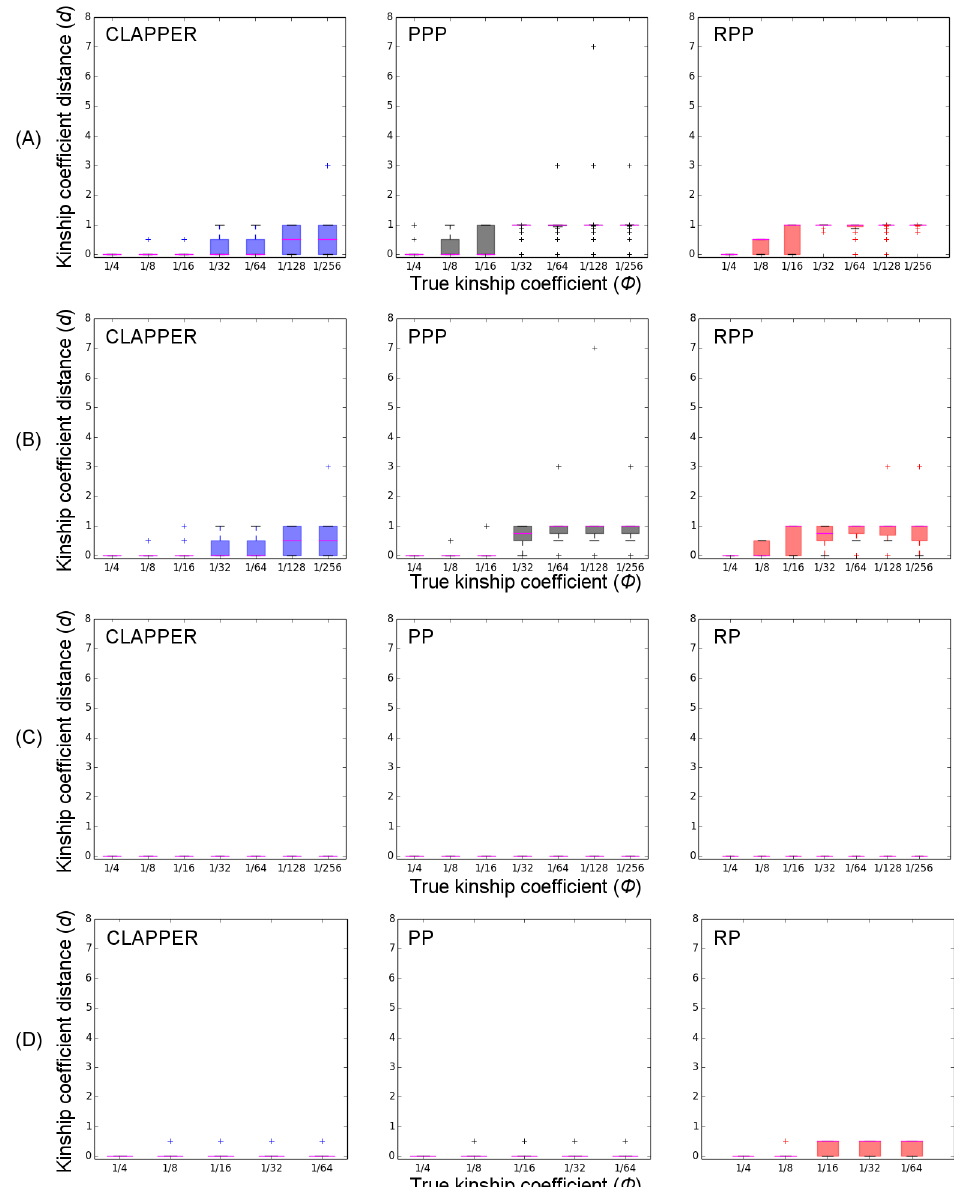
Fig 4. Absolute between the expected kinship coefficient under true and inferred relationships, normalized by the true kinship coefficient. (A) simulationA; (B) simulationB; (C) simulationC; (D) simulationD. The x-axis is the relationshipcategory measuredby the kinshipcoefficient; the y-axis is the distance d betweenthe true relationship and the relationshipestimated by our method (See Measuring the Error Rate in Materials and methods section). The magenta line indicatesthe medianvalue for each box plot. Analysis excludesall experiments that did not finish successfully or did not produceany outbred